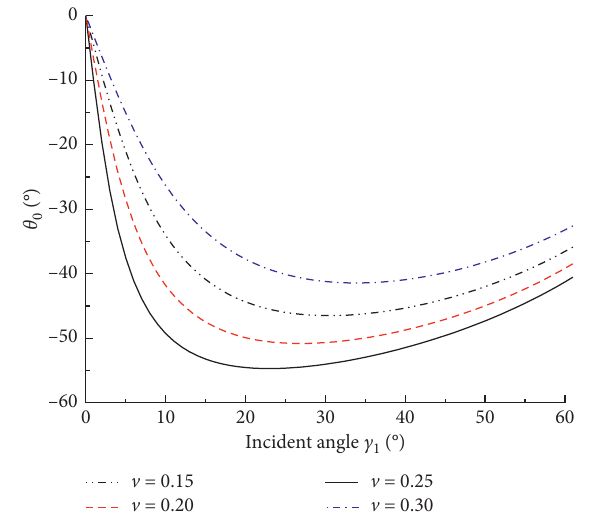
Figure 9: Variation of θ